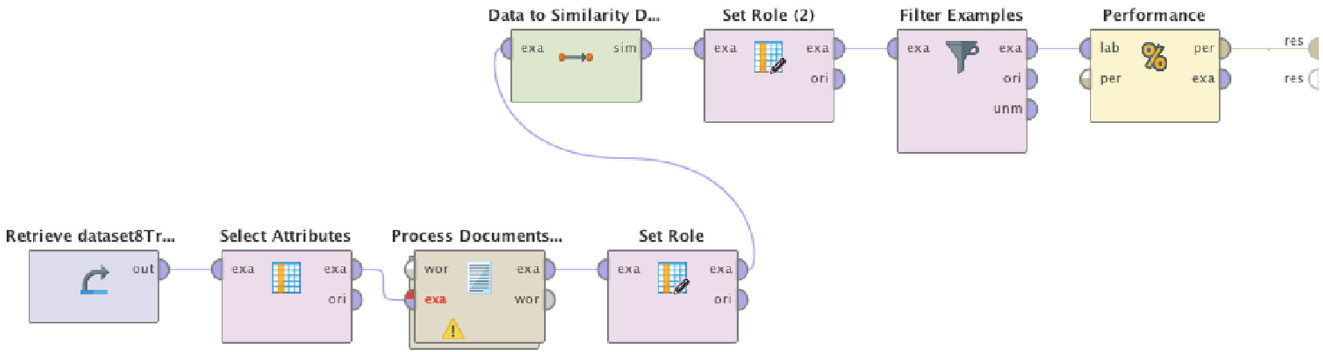
Fig 6. RapidMiner process model.